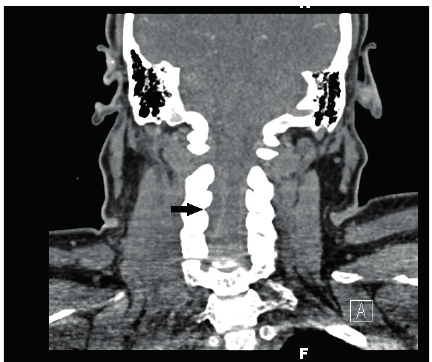
Figure 1: CT of the neck revealing a 3.7 by 1.4cm low-density oval lesion (arrow) displacing the thecal sac and extending from the C2 to the C4